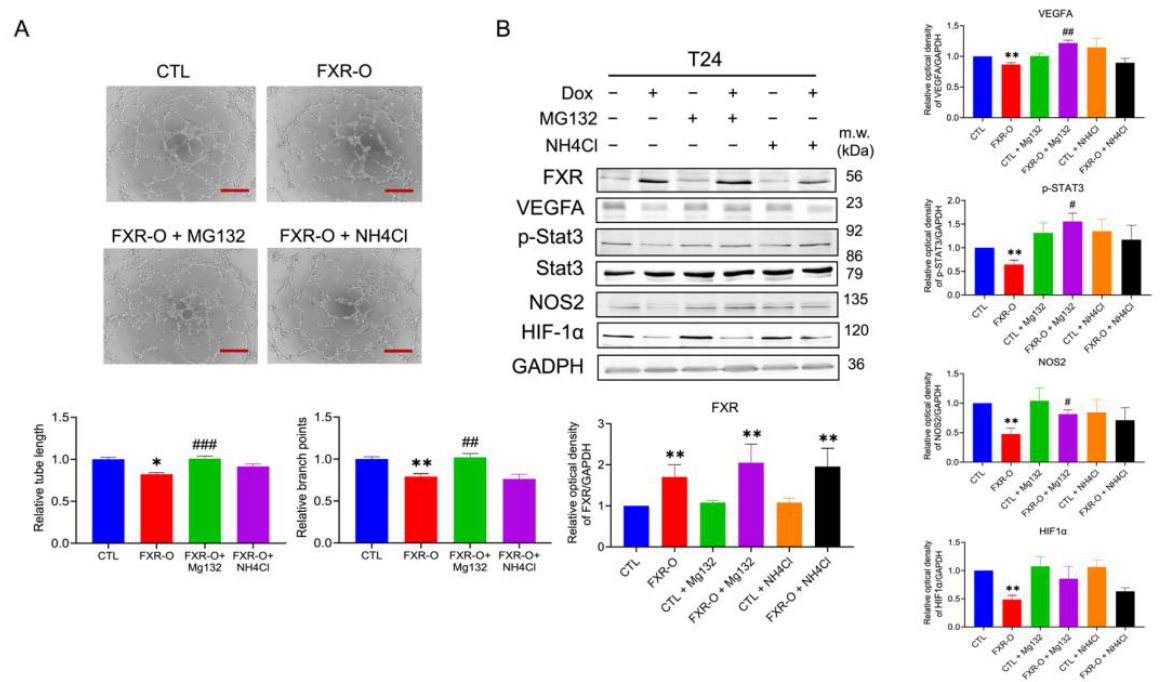
Figure 9. The effect of proteosome inhibitor MG132 and lysosome inhibitor NH4Cl on the angio- genic abilities after FXR overexpression. ( A ) The human umbilical vein endothelial cells (HUVECs) were cultured with FXR overexpressed conditioned medium (CM) and control CM with or without MG132 or NH4Cl of bladder cancer cells for 6 h. The formation of an endothelial cell network was